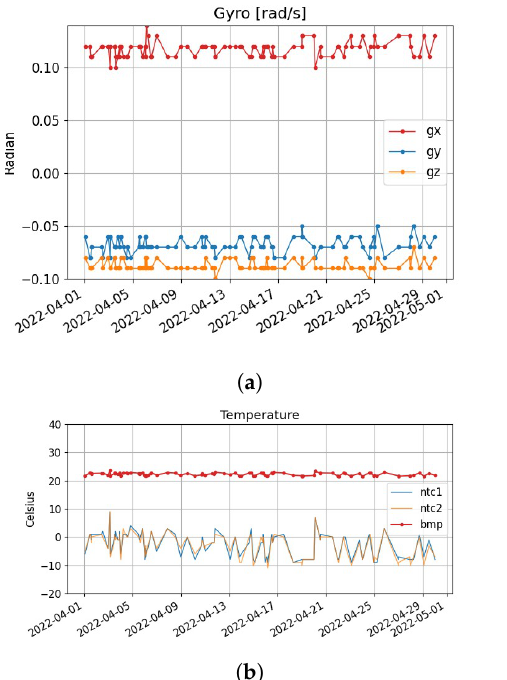
Figure 10. ( a ) The angular speed of SATLLA-2B in each axis, as captured by the onboard MEMS- gyro. ( b ) The temperature (in Celsius) of the satellite as sensed in the batteries ( rtc 1 , rtc 2 ) and in the satellite’s IMU ( bmp